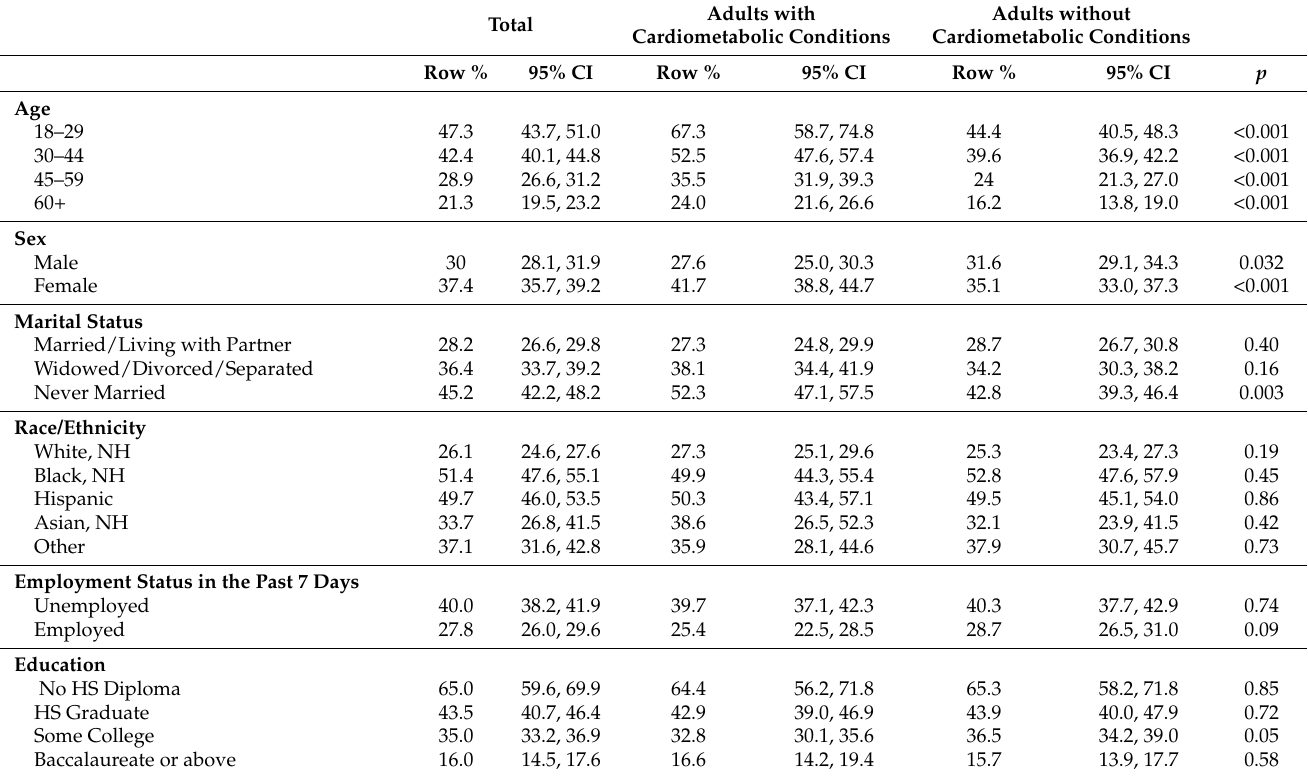
Table 2. Prevalence of food insecurity by cardiometabolic condition status among COVID Impact Survey respondents ( n = 10,760), a nationally representative survey of the US (April–June 2020). Adults with Adults without Total Cardiometabolic Conditions Cardiometabolic